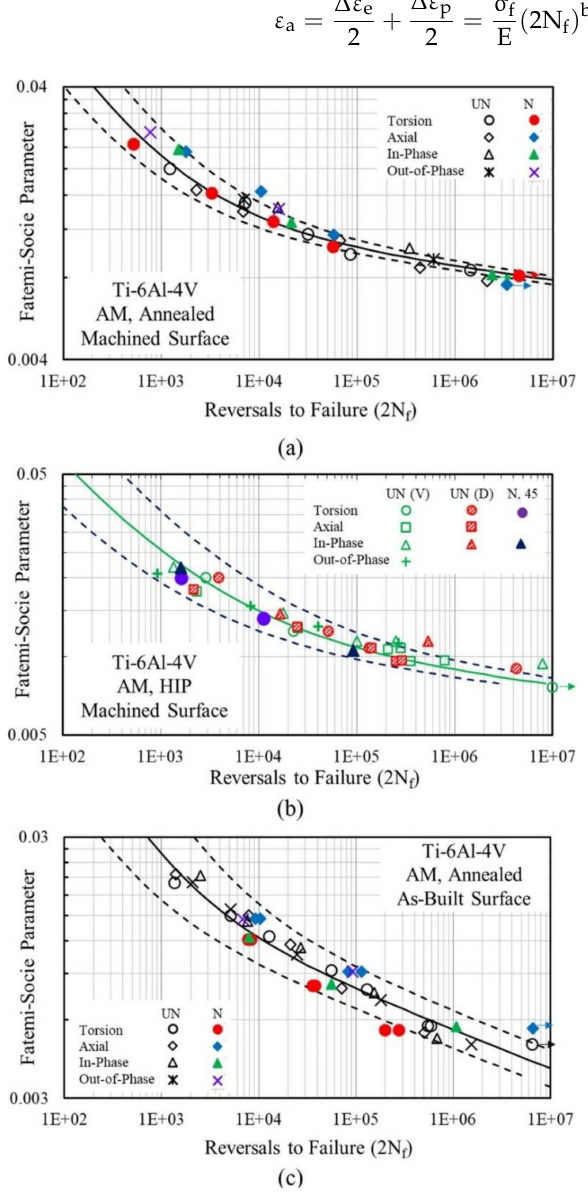
Figure 15. Notched (N) and unnotched (UN) Ti-6Al-4V fatigue data correlations of machined surface annealed ( a ), machined surface HIPed ( b ), and as-built surface annealed ( c ) conditions based on FS damage parameter. HIPed specimens in part ( b ) were built vertically (V) and diagonally (D). For machined samples, the transverse hole was induced by drilling, while for as-built surface, it was built during the AM process. Reprinted with permission from ref. [75]. 2021,